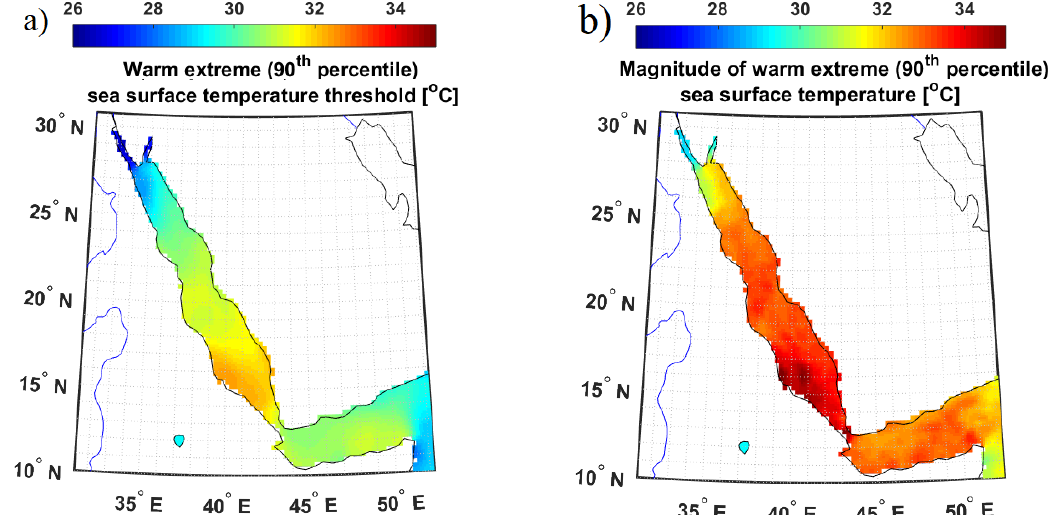
Figure 3. Spatial distribution of the threshold ( a ) and magnitude ( b ) of warm SST ETEs (90th percentile) over